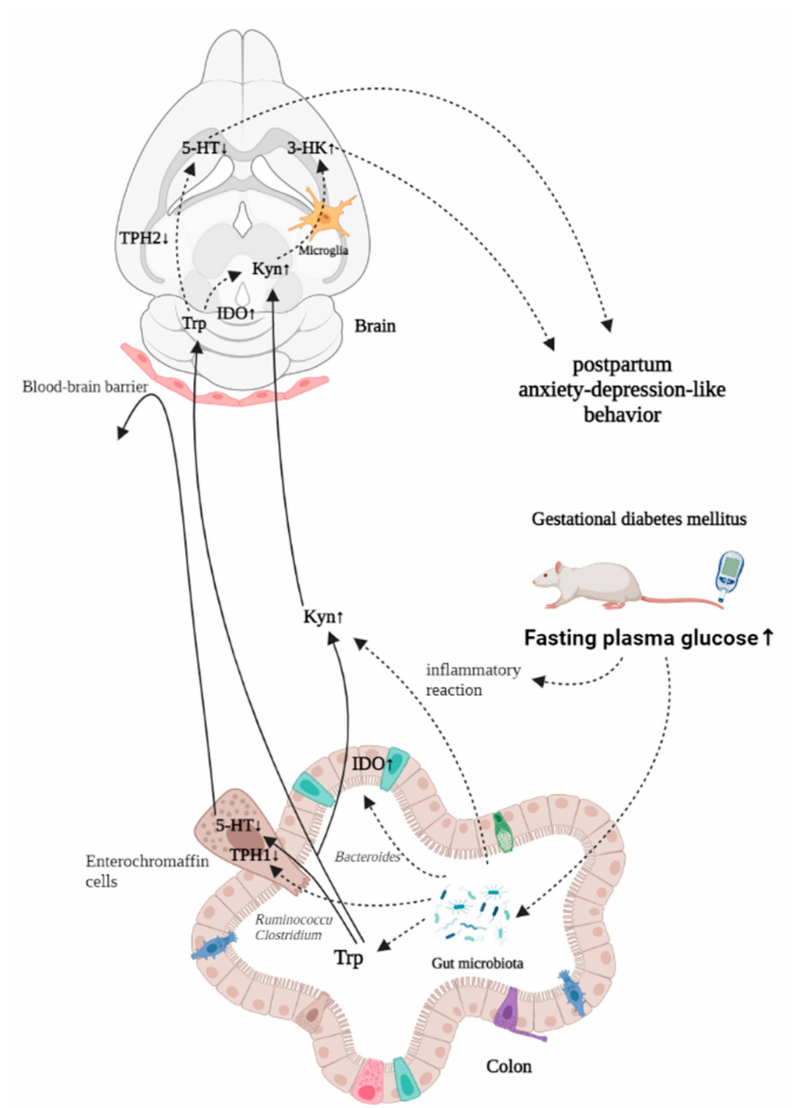
Figure 12. The microbial-gut-brain axis model of postpartum depression-like behavior induced by